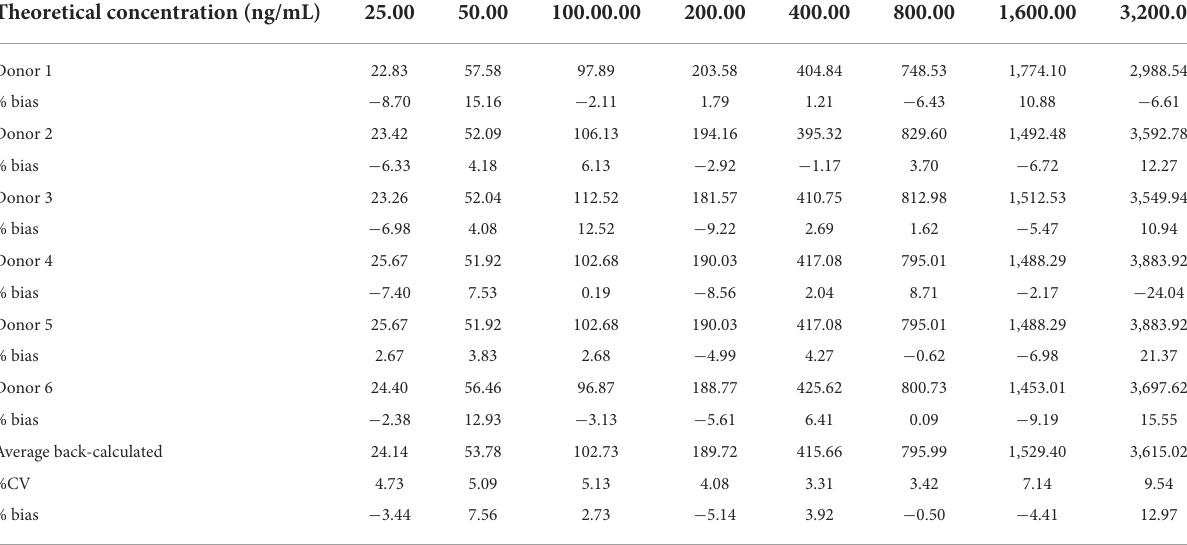
TABLE 1 The back-calculated concentrations and accuracy of the recombinant canine PD-1 fusion protein on calibration curve from 6 independent experiments. Theoretical concentration (ng/mL)